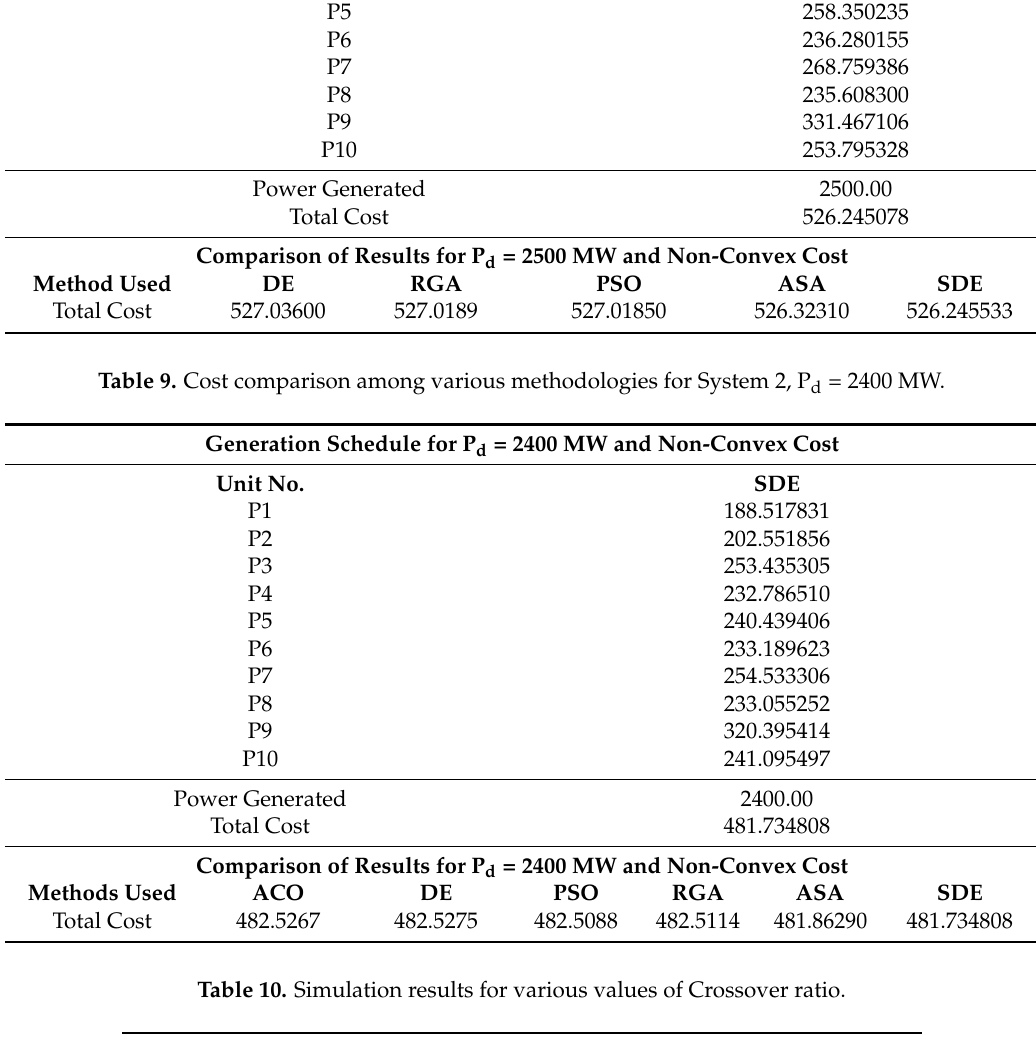
Comparison of Results for P d = 2400 MW and Non-Convex Cost